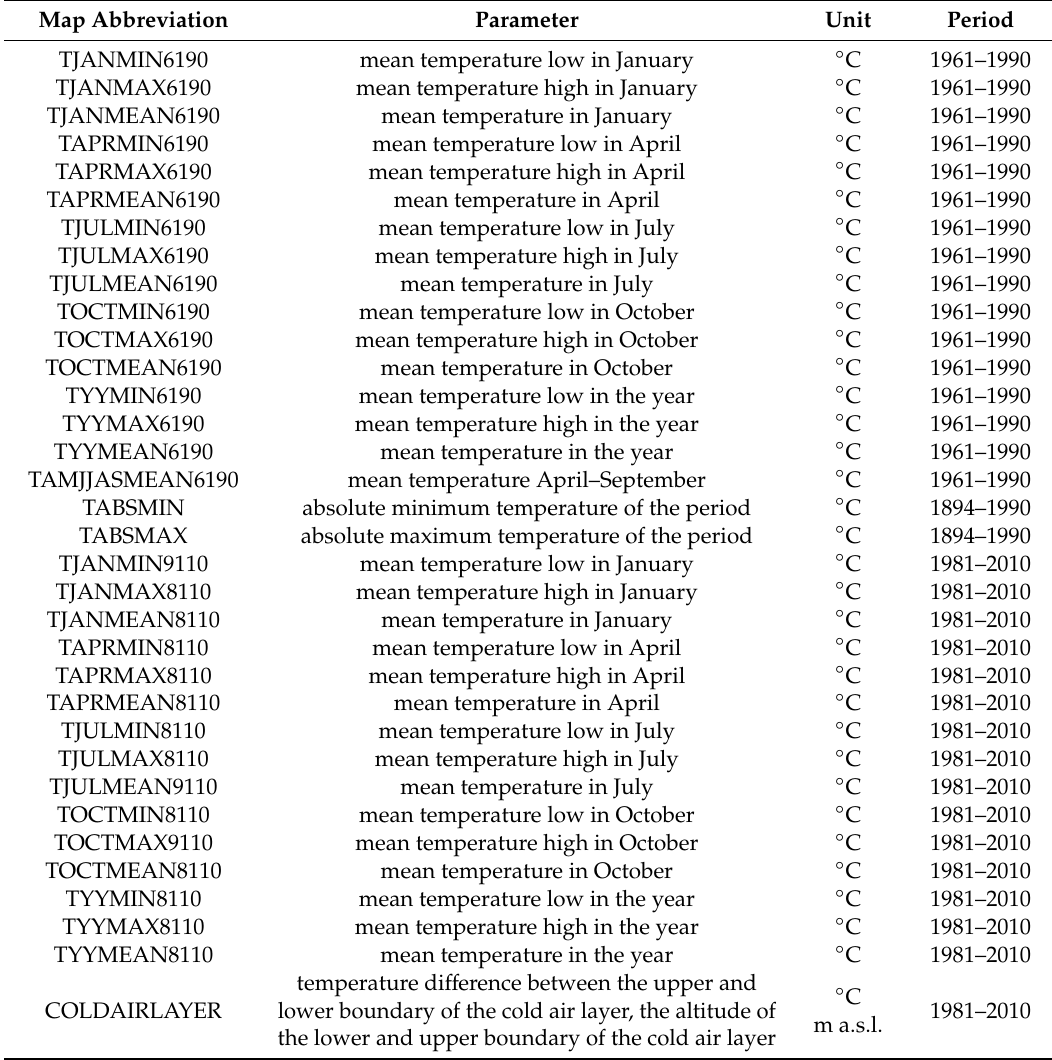
Figure 1. Mean daily temperature low (left) and (high) during the year in the period 1981–2010. Table 1. Resulting temperature maps and intermediary files.